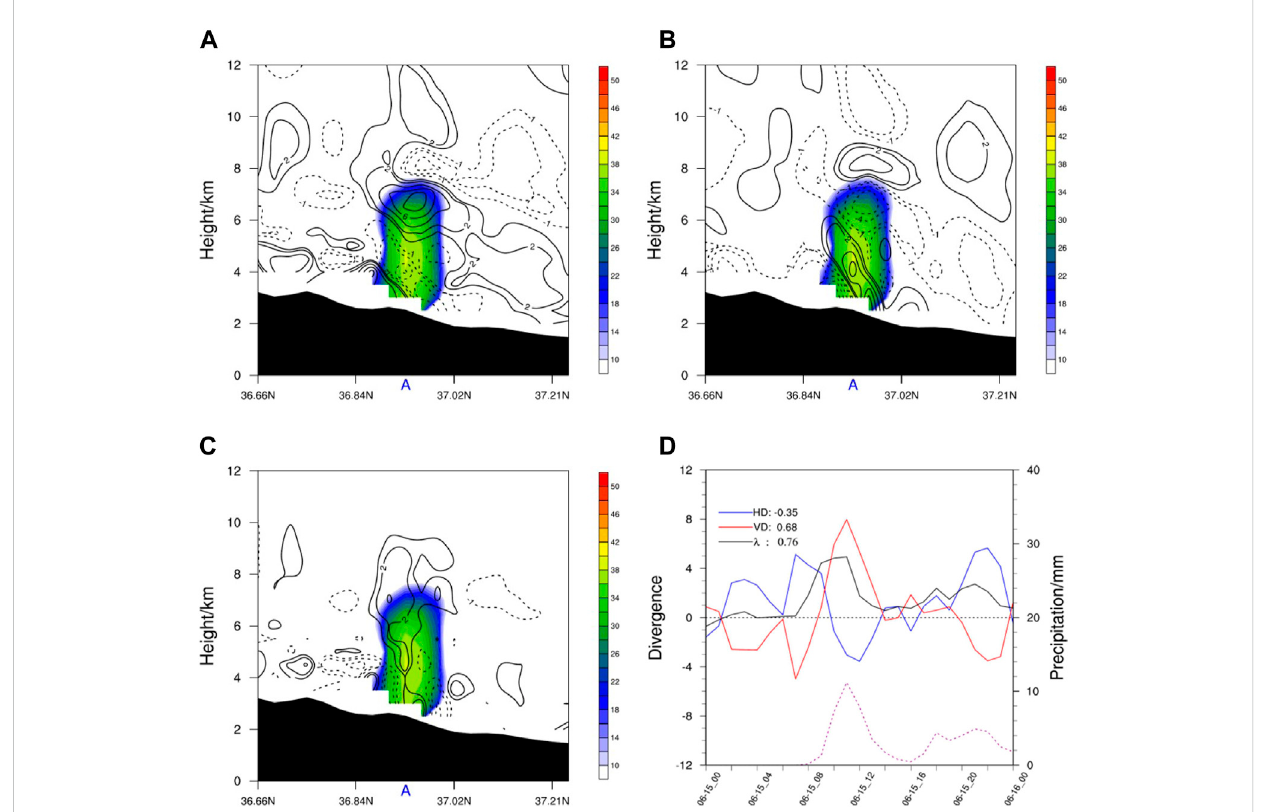
FIGURE 4 Cross sections of re fl ectivity (shadings, units: dBZ) and (A) horizontal divergence (black contours, units: 10 – 4 s -1 , dotted line for negative value), (B) vertical divergence (black contours, units: 10 – 4 s -1 ), and (C) three-dimensional divergence (black contours, units: 10 – 4 s -1 ) along 78.91 ° E at 0700 UTC on 15 June 2021; (D) time series of domain-mean horizontal divergence (blue line, units: 10 – 4 s -1 ), vertical divergence (red line, units: 10 – 4 s -1 ), and three- dimensional divergence (black line, units: 10 – 4 s -1 )integrated from 2 km to7 kmand hourly precipitation(purpledotted line,units: mm). “ A ” denotes the convection position. The values on the right side of the legend denote the linear correlation coef fi cient between divergence and simulated precipitation in panel (D) . The values in panel d are averaged within 30×30 km around 79 ° E, 37.15 °